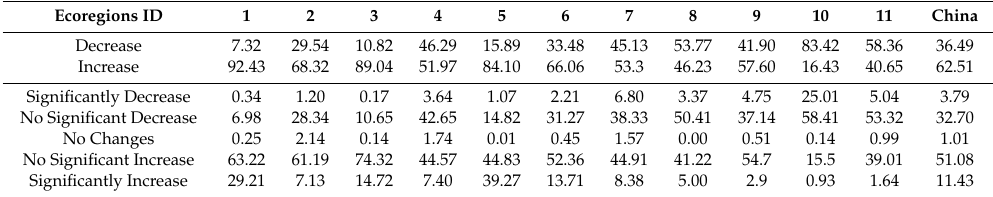
Table 1. The area proportions (%) of the di ff erent classifications of the linear trend of WP in eleven ecoregions and the whole of China from 2000 to 2013. Ecoregions